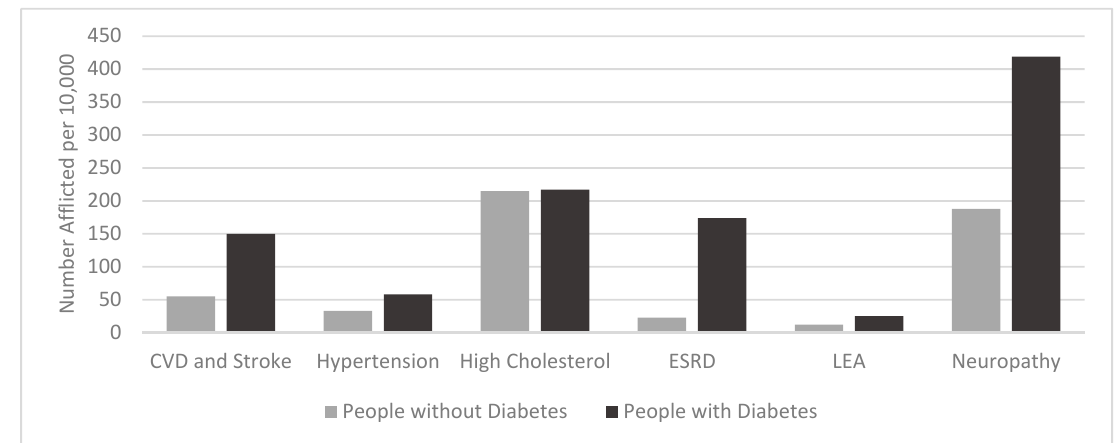
Figure 3. Common comorbidities and complications of DM in the US population as compared to the incidence in those not afflicted with DM [8,33–39]. At least 34.2 million Americans have DM. DM was directly attributed to about 80,000 deaths in the US. and it was a contributing cause for an additional 252,806 deaths in 2015 [8]. ESRD: End Stage Renal Disease. LEA: Lower Extremity Amputation.